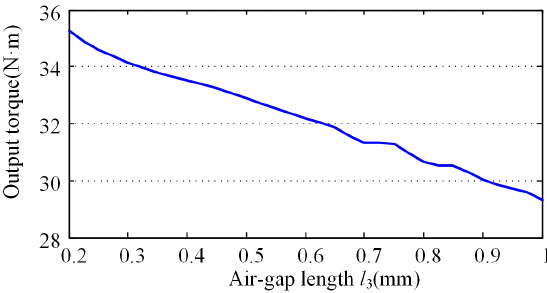
Figure 5. Output torque versus air-gap length l 3 .